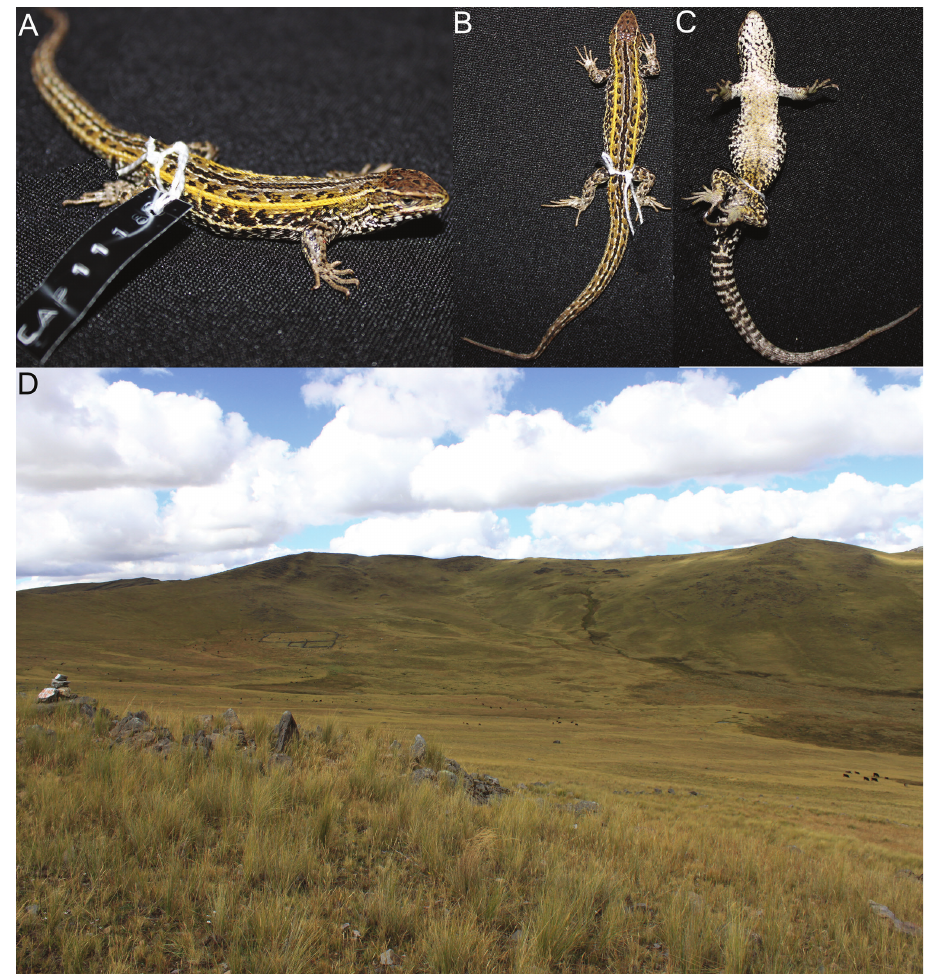
Figure 10. Lateral ( a ) dorsal ( B ) and ventral ( C ) views of the holotype of Liolaemus wari sp. n. ( D ) Type IV: 16; V: 10 (right fingers). Claws moderately long. Supradigital lamellae convex, smooth, and imbricate. Infracarpals and infratarsals keeled, distinctly imbricate. Supra- tarsals smooth. Subdigital lamellae of toes I: 8; II: 12; III: 16; IV: 20; V: 13 (left toes). Color pattern in preservation. Dorsal background color from occiput to base of tail brownish-green. Black continuous vertebral line present. Dark paravertebral marks. Paravertebral and vertebral fields with same background color. Highly distinct creamy-yellow dorsalateral stripes. Large dark and small cream marks in lateral field. Cream ventrolateral stripe, beginning on the posterior corner of the eye, continuing across the upper auricular meatus, the longitudinal neck fold, through the shoulders, ending in the groin. Dark and cream small marks in the ventral field. Black spots